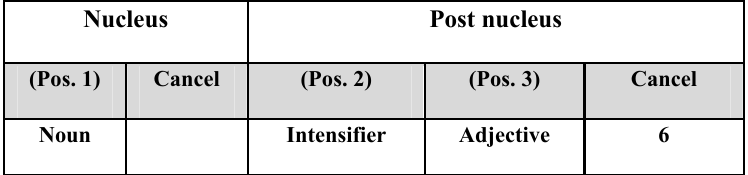
Table IX. Three constituents NPs within the STP sample Nucleus Post